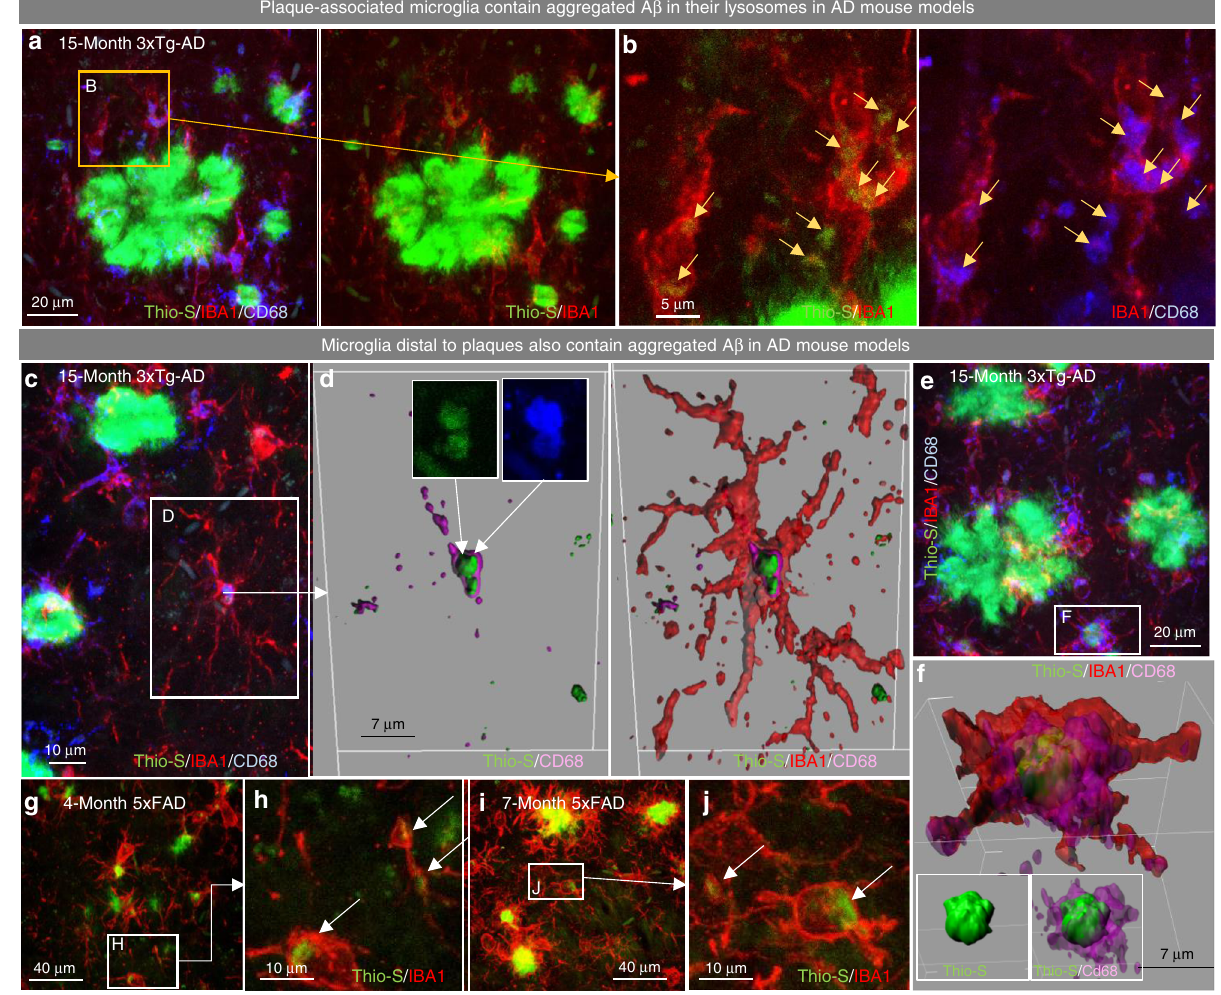
Fig. 1 Plaque-distal microglia contain aggregated A β . a – e 15-month-old 3xTg-AD mice were stained for dense core deposits with Thio-S (in green), and immunolabeled for microglia (IBA1 in red) and macrophage lysosomes (CD68 in blue; a , c , and e ) with zoomed image ( b ) of Thio-S + material within microglia and within lysosomes, separately. Scale bars = 20 μ m for a , e 5 μ m for b , 10 μ m for c . d , f Three-dimensional reconstruction of microglia (IBA1 in red), the microglial lysosome (CD68 in purple), and fi brillar A β (Thio-S in green), demonstrating the localization of A β to the microglial lysosome in non- plaque associated microglia. Scale bars = 7 μ m. g – j 5xFAD animals stained for dense-core deposits (Thio-S in green) and immunolabeled for microglia (IBA1 in red; g and i ), with zoomed images ( h , j ) demonstrating Thio-S + aggregates in microglial cell bodies in 4- and 7-month-old 5xFAD mice. Scale bars = 40 μ m for g , i 10 μ m for h ,